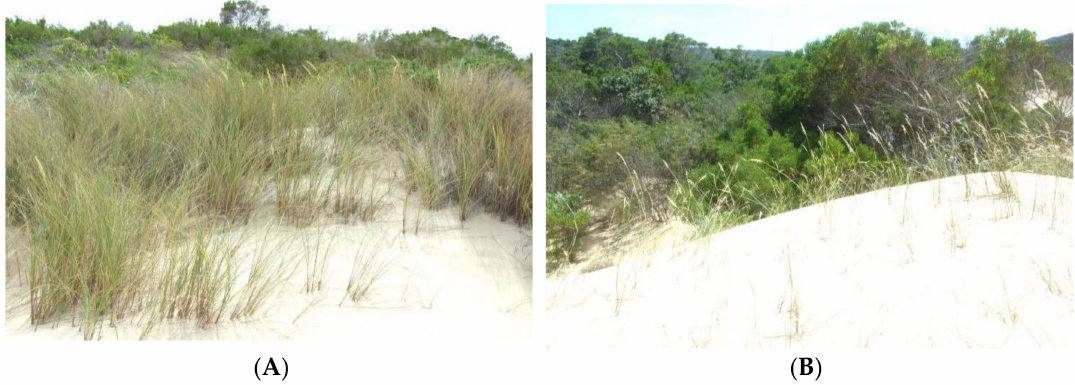
Figure 5. ( A ) Ammophila arenaria (marram grass) at Oyster Bay being replaced by shrubs with coastal scrub in the distance. ( B ) Ehrharta villosa (pypgras) at Hamburg on the rear dunes, where it is replaced by shrubs such as Passerina rigida (dune